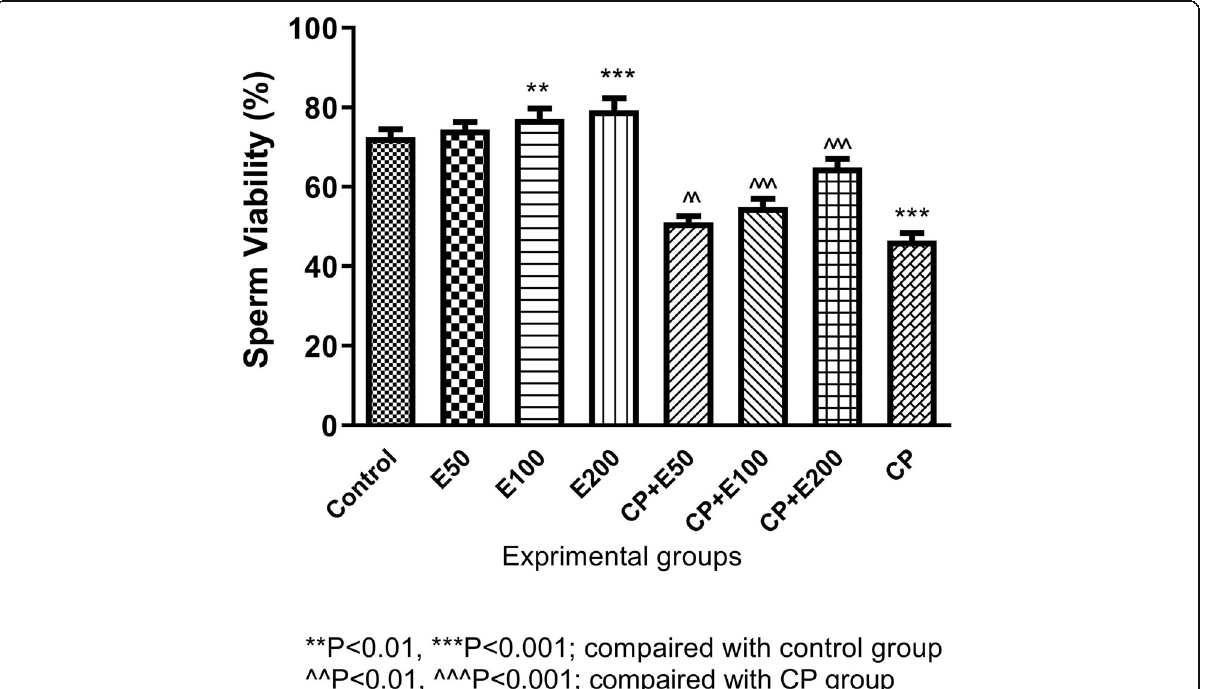
Fig. 5 The effect of Allium atroviolaceum L. extract (E) on sperm viability in cyclophosphamide (CP)-treated mice